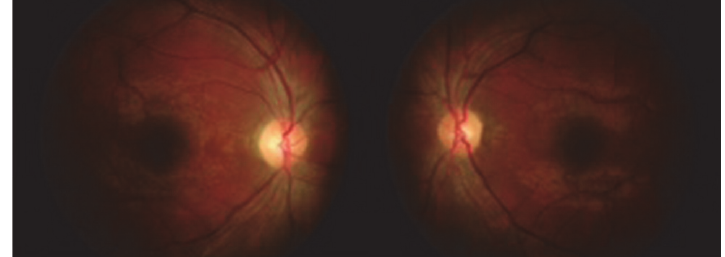
Figure 3: Fundus photo after six weeks of treatment showing resolution of the optic disc swelling and haemorrhages